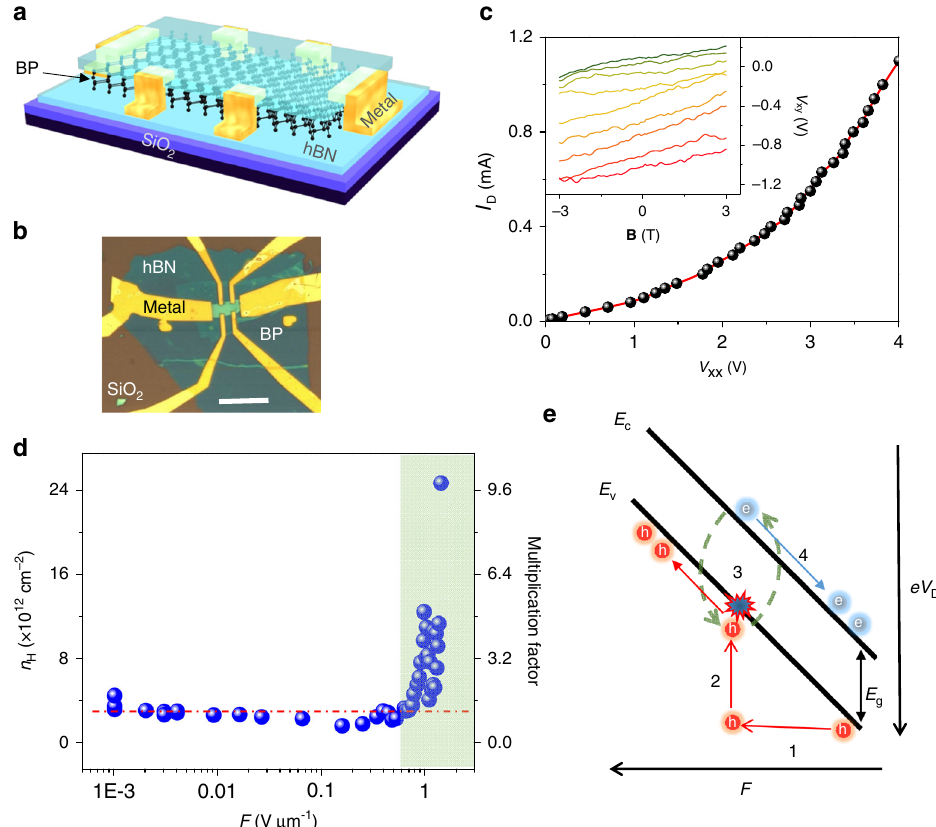
Fig. 3 Magneto-transport measurements collected from a multilayer BP device. a , b show schematic and optical images, respectively, of hBN – encapsulated Hall-patterned BP device. The thickness of hBN top, BP, and hBN bottom is 9, 28, 15 nm, respectively, and scale bar is 10 µ m. c The channel voltage drop ( V xx ) and the applied source-drain current ( I D ). Inset: Hall voltage ( V xy ) as a function of the magnetic fi eld at V G = – 50 V at a given I D . For ease of viewing, a few data plots are shown from 0.2 mA (green) to 1 mA (red) I D with step of 0.1 mA. d Carrier concentration ( n H ) as a function of the applied I D and electric fi eld, where blue circles are data points and red dashed line indicates mean n H value at low fi eld. e Energy Band diagram showing carrier multiplication in the BP channel, where E c , E v , and E g represent conduction band edge, valance band edge and energy band gap of BP,